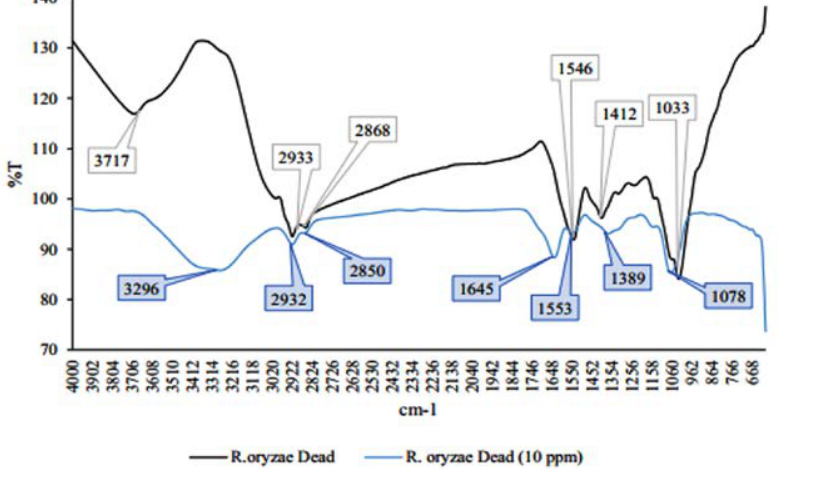
Fig. 4 . FTIR data of dead cells of R. oryzae before and after the absorption in 10 ppm Hg